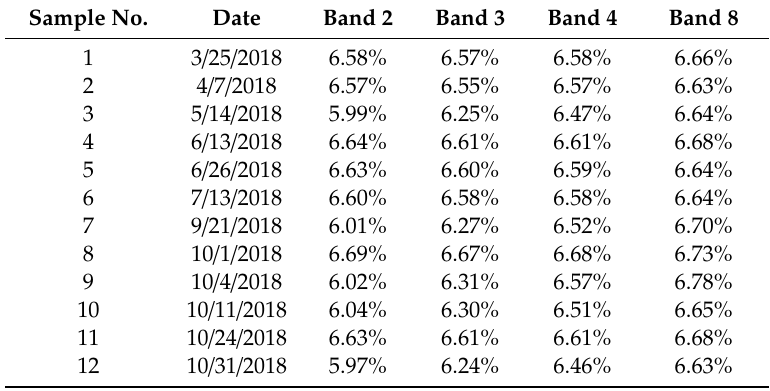
Table 7. The uncertainty of the relative di ff erence between the simulation and observation in bands 2, 3, 4, and 8 of Sentinel-2B /